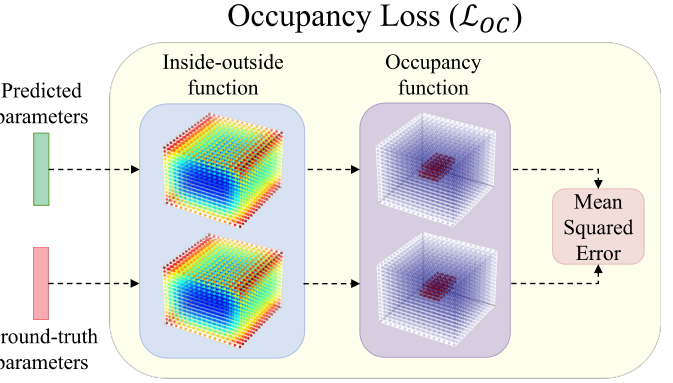
Figure 3. Visualization of the learning objective. To train the CNN predictor for superquadric recovery, we used a geometry-aware loss function based on the 3D occupancy grids constructed from predicted and ground truth